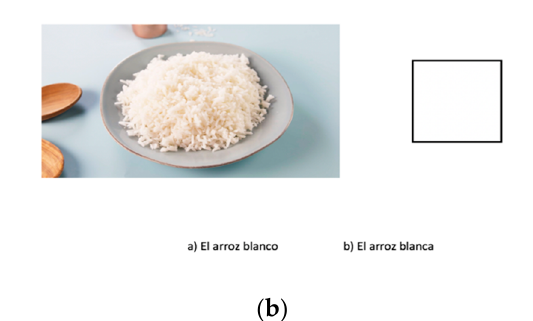
Figure 1. Samples of ( a ) the elicited production task (EPT) and ( b ) the forced choice task (FCT) testing a non-canonical masculine noun.